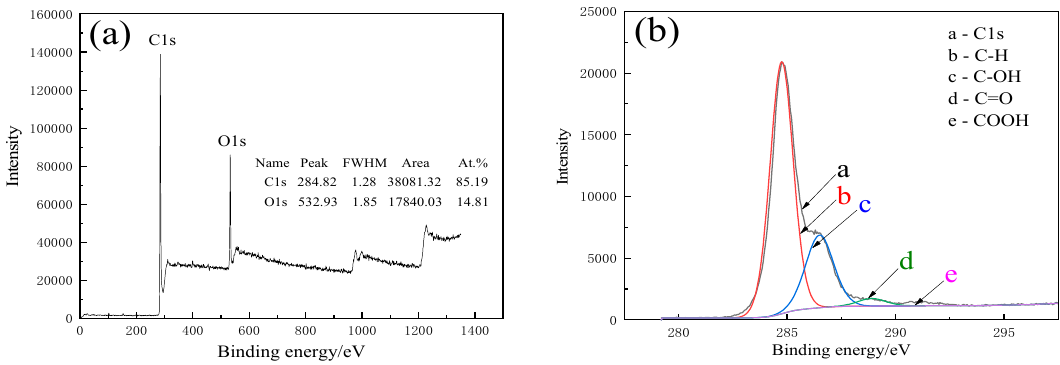
Figure 8. XPS spectra of the degummed braided carbon fiber rope: ( a ) survey XPS spectra; ( b ) C1s spectra. Table 3. Functional group content on the surface of pretreated braided carbon fiber